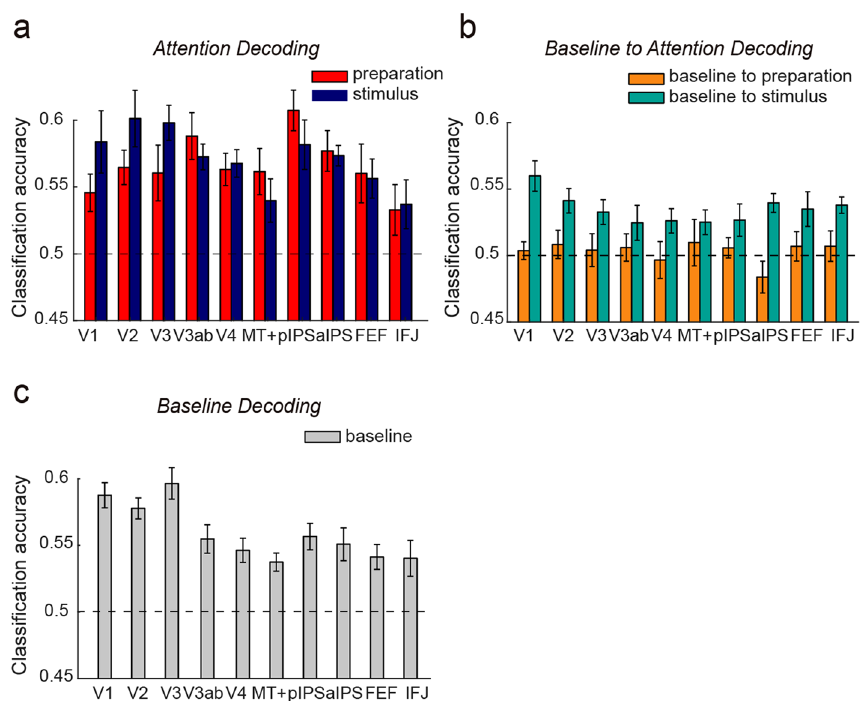
Figure 3. ( a ) Decoding the attended motion direction during preparation (red bars) and stimulus period (blue bars) in individual brain areas. ( b ) Cross-task generalization from baseline task to preparation (yellow bars) and stimulus periods (cyan bars) in the motion-based attention task. ( c ) Decoding the direction of the motion stimulus in the baseline task. The black dashed lines denote theoretical chance level (0.5), which is plotted here for visualization purpose only. Note that the evaluation of the statistical significance of decoding accuracy is based on permutation tests. Error bars denote within-subject errors.